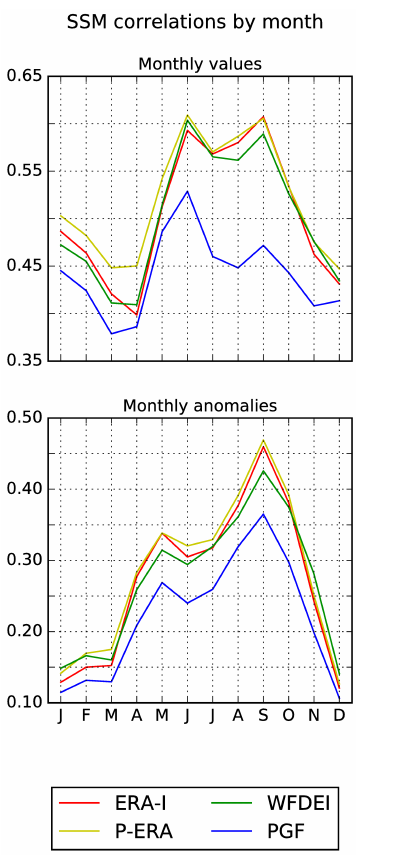
Figure 4. Annual cycles of correlation between modelled and re- motely sensed ESA-CCI SSM for monthly averages and anomalies. Coefficients are computed separately for each calendar month.